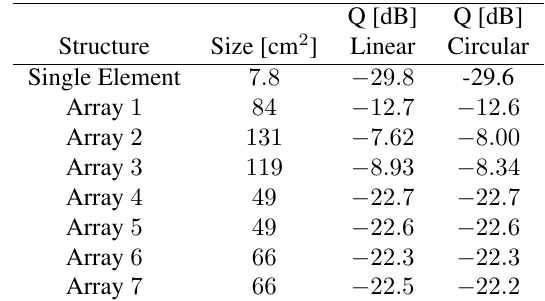
Table 1: Sizes and general performances of the arrays in Fig.